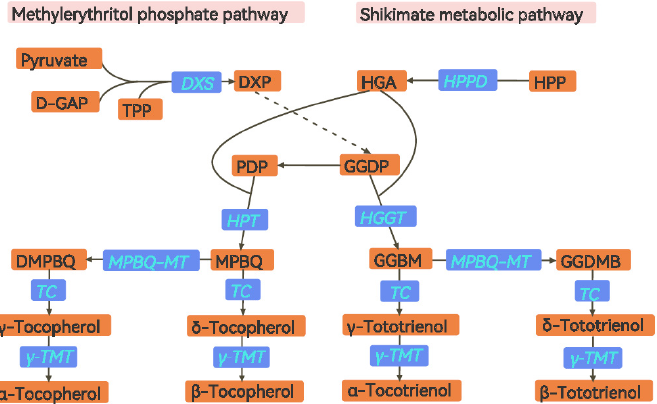
Figure 1. Vitamin E biosynthesis pathway in rice. D ‐ glyceraldehyde ‐ 3 ‐ phosphate (D ‐ GAP), thiamine pyrophosphate (TPP), 1 ‐ deoxy ‐ d ‐ xylulose ‐ 5 ‐ phosphate (DXP), DXP synthase (DXS), 4 ‐ hydroxyphenylpyruvate (HPP), 4 ‐ hydroxy ‐ phenylpyruvate dioxygenase (HPPD), homogentisic acid (HGA), geranylgeranyl diphosphate (GGDP), phytyldiphosphate (PDP), homogentisate phytyltransferase (HPT), homogentisate geranylgeranyltransferase (HGGT), 2 ‐ methyl ‐ 6 ‐ phytylquinol (MPBQ), 2,3 ‐ dimethyl ‐ 5 ‐ phytylquinol (DMPBQ), MPBQ methyltransferase (MPBQ ‐ MT), tocopherol cyclase (TC), γ‐ tocopherol methyltransferase ( γ‐ TMT), 6 ‐ geranylgeranyl ‐ 2 ‐ methylbenzene ‐ 1,4 ‐ diol (GGBM), 6 ‐ geranylgeranyl ‐ 2,3 ‐ dimethylbenzene ‐ 1,4 ‐ diol (GGDMB). Same below, as shown in Table A1.